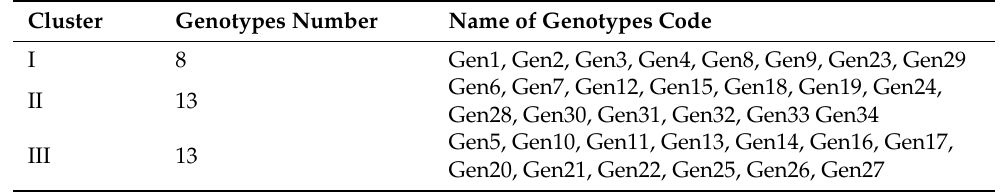
Table 6. Clustering of 34 elite rice breeding lines.